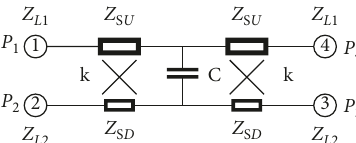
Figure 2: Structure of a section of transdirectional coupler with shunt capacitor